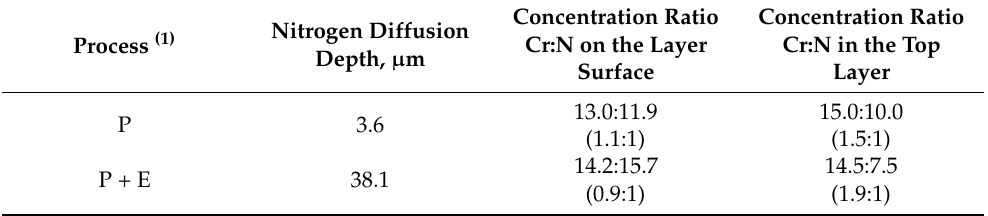
Table 4. The depth of nitrogen diffusion and the Cr:N concentration ratio after various variants of glow discharge nitriding. Concentration Ratio Concentration Ratio Nitrogen Diffusion Cr:N in the Cr:N on the Layer Process (1) Depth, µ m Surface